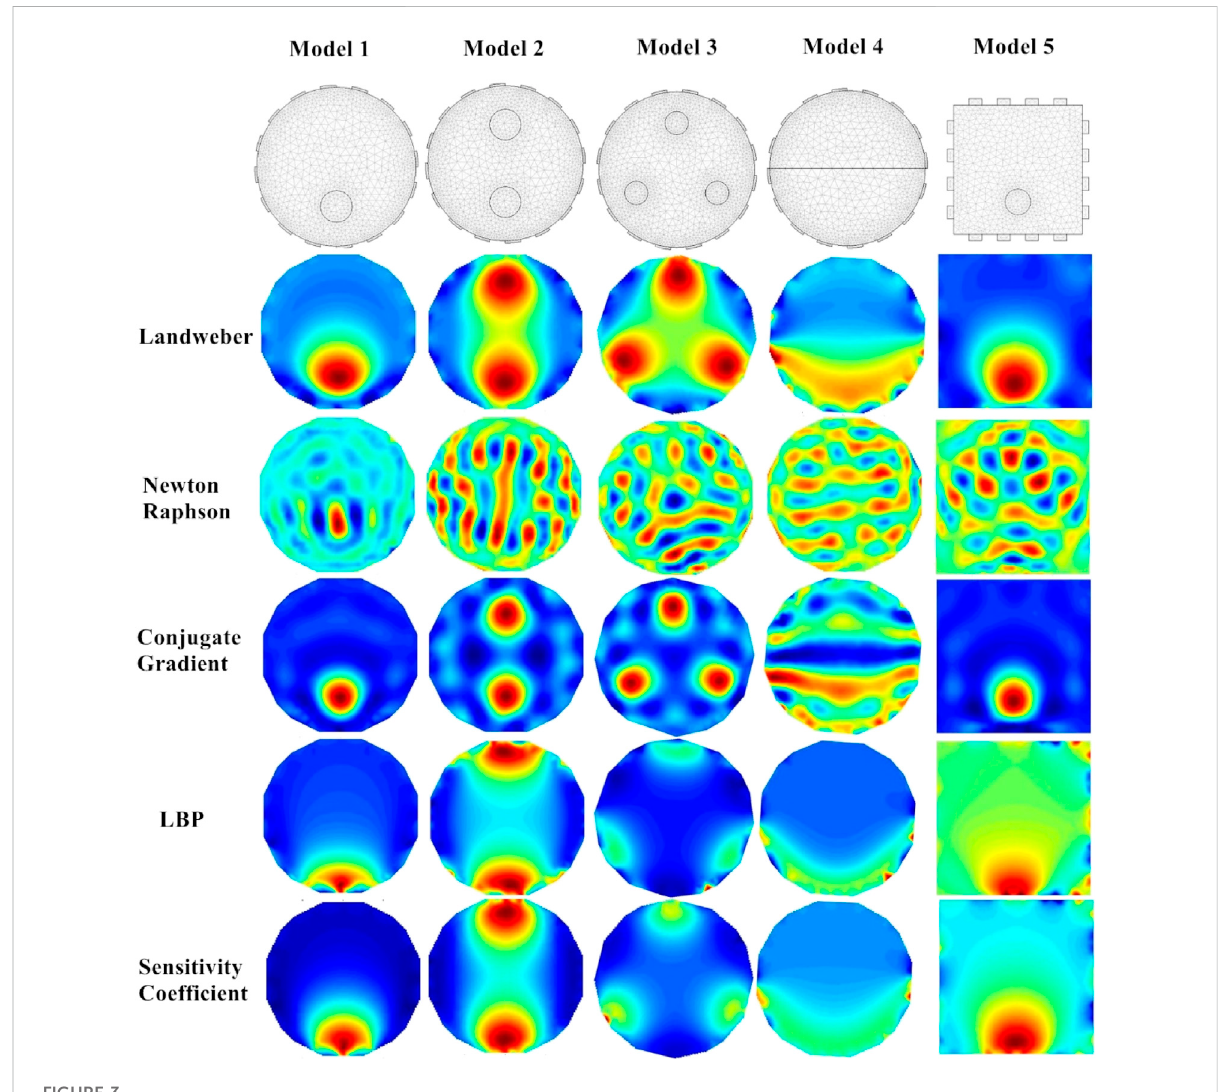
FIGURE 3 Reconstruction results of 5